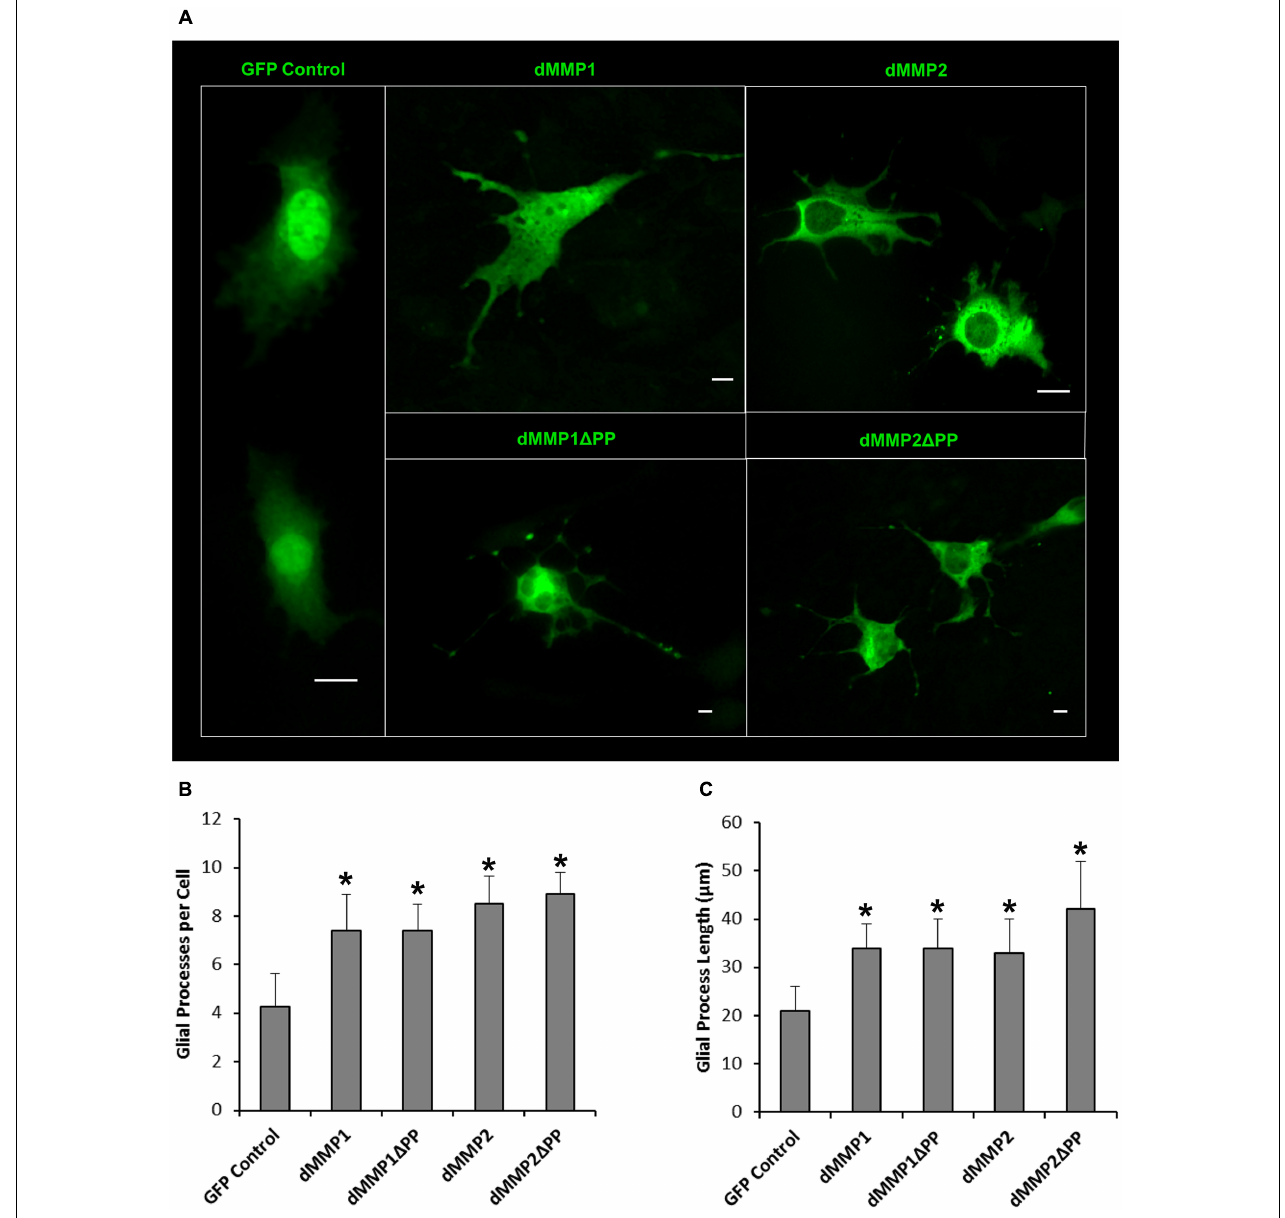
FIGURE 8 | Expression of dMMPs induced glial process formation in C6 glioblastoma cells. (A) Glial-like morphology of C6 cells transfected with GFP Control and GFP-dMMP constructs. Some images are zoomed out to capture total cell size and shape. Each scale bar = 10 µ m regardless of zoom. (B) Number of glial processes per cell (Mean ± SE) in GFP Control and GFP-dMMP transfected cells. (C) Glial process length ( µ m) (Mean ± SE) in GFP Control and GFP-dMMP transfected cells. Data are averaged across three independent experiments. Bars with * represents significant difference compared to control at p <